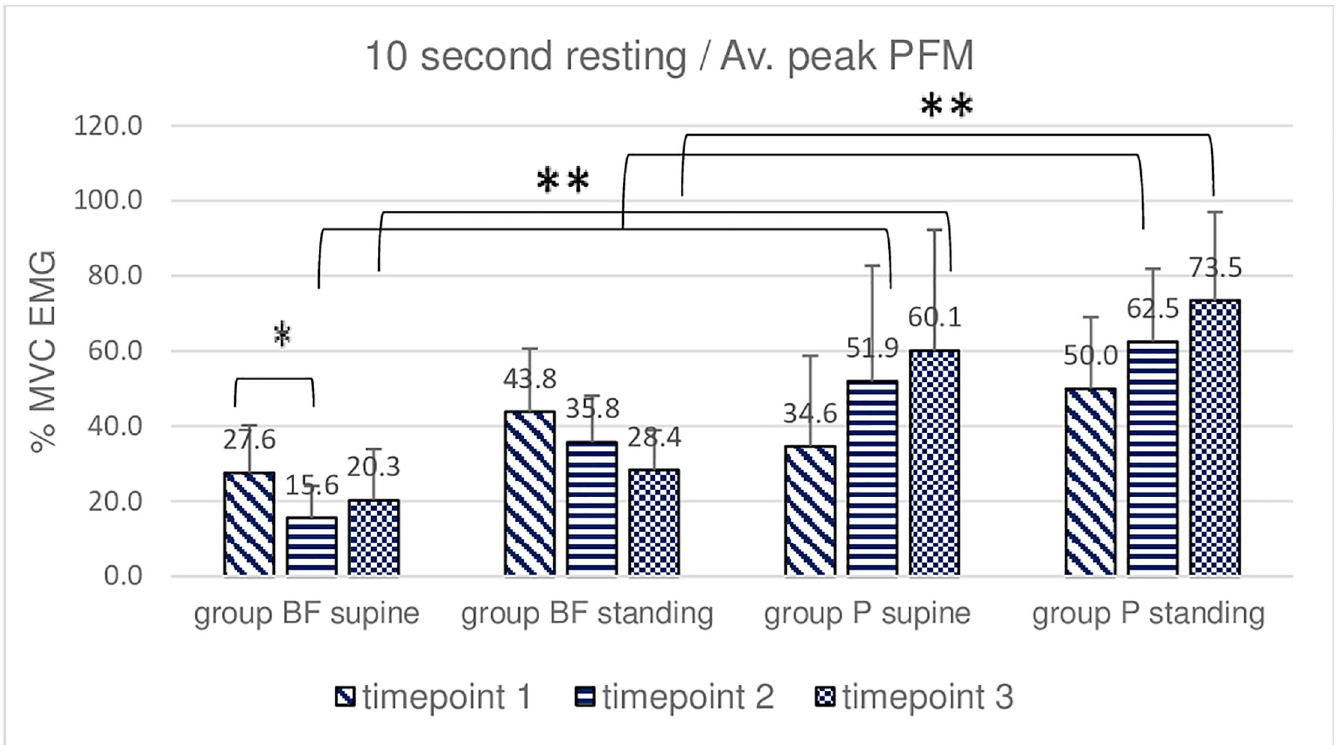
Fig 2. Intra- and intergroup analysis of sEMG average peak %MVC amplitudes of the resting activity of pelvic floor muscles; p � Post-hoc Friedman’s rank sum test; p �� Mann- Whitney U test.